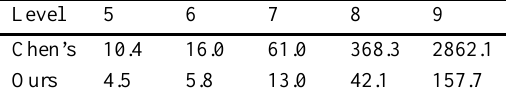
Table 2. Generating times of the two